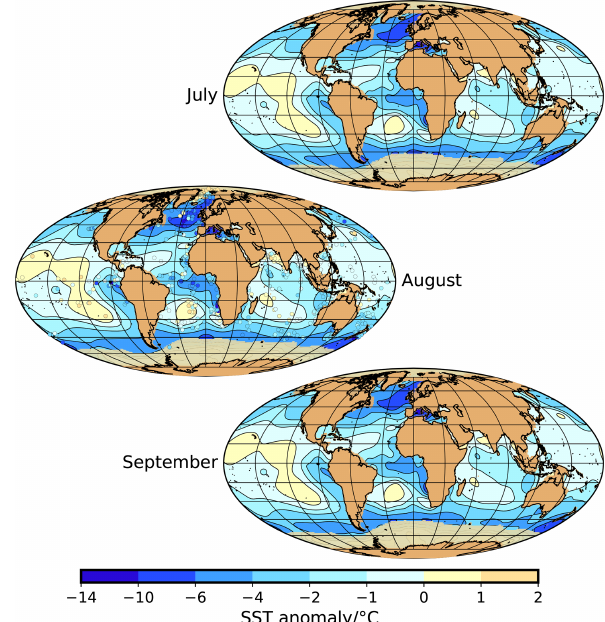
Figure A4. Sea-surface temperature anomaly (contour map) and sea-ice extent (yellow–brownish areas close to Antarctica and in the Arctic) for April, May, and June.